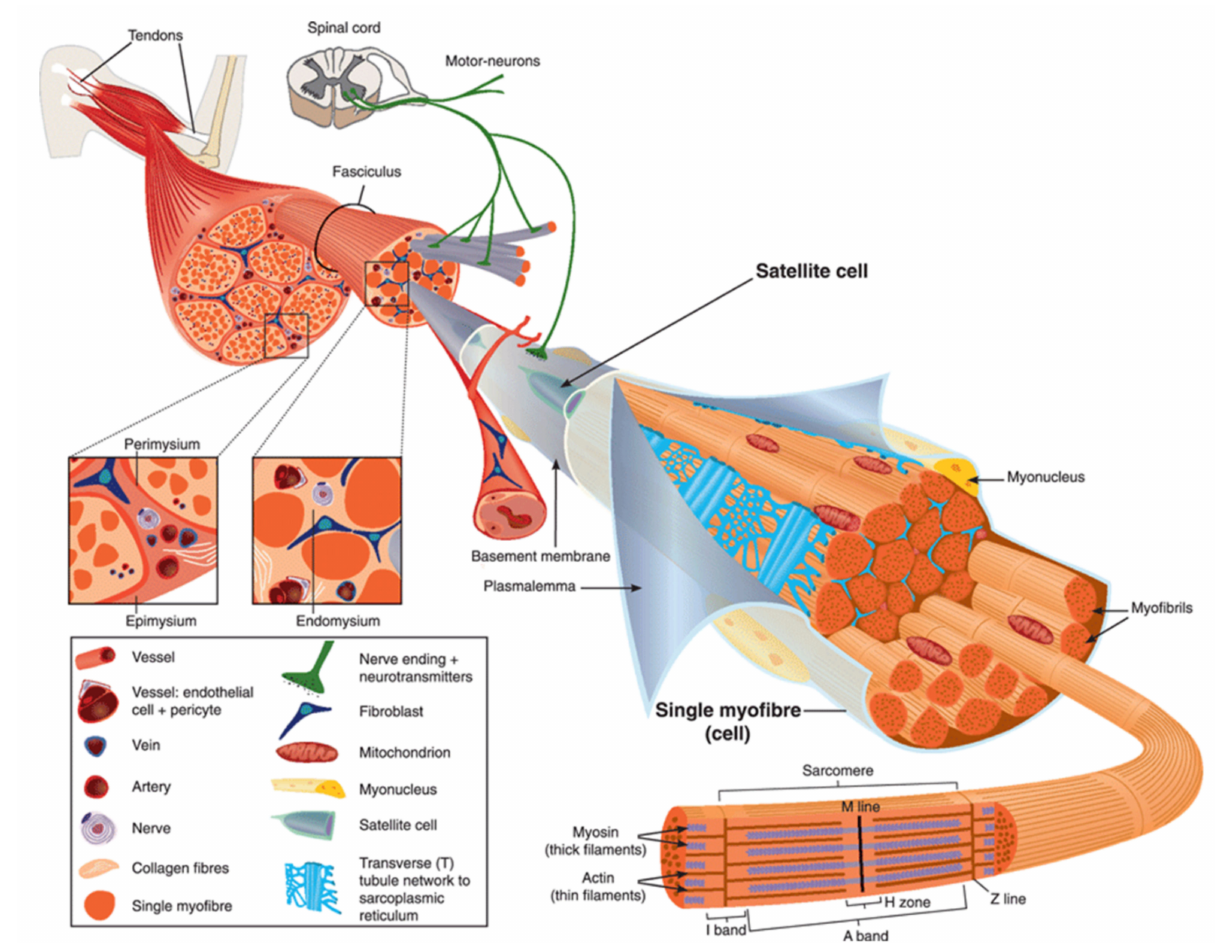
Figure 1. Scheme of skeletal muscle and associated structures. ( Left-hand part ) Epimysium, perimysium, and endomysium constitute three connective tissue layers that form the lattice network and associated basement membranes in which myofibers regenerate after injury. The epimysium is the outer layer that surrounds the entire muscle and is contiguous with the tendon and endosteum (fascia surrounding bone). The perimysium surrounds bundles of myofibers. The endomysium is located between individual muscle fibers. ( Right-hand part ) Satellite cells are located between basement membrane and sarcolemma. Sarcolemma bounds each myofiber, which is composed by multiple nuclei and the sarcoplasm that contains mitochondria, sarcoplasmic reticulum and myofibrils. The myofibril is the contractile unit of a myofiber. Specialized cytoskeleton within the myofibril forms repeated structures, called sarcomeres, which appear as a succession of light and dark bands under polarized light optical microscopy. The sarcoplasmic reticulum is the major provider of Ca 2+ required for muscle contraction. It is connected to transverse tubules that surround sarcomeres. Adapted from Reference [15] with the Permission 5036470714502 from John Wiley and